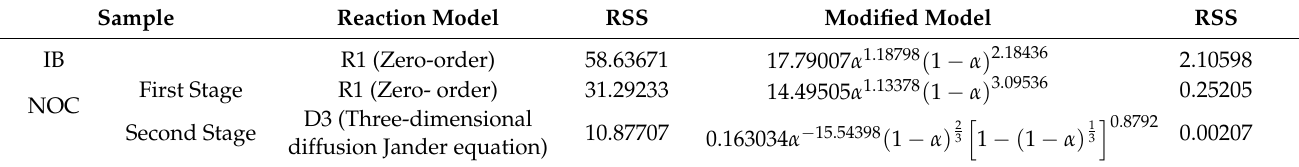
Figure 7. Model reconstruction of the kinetic mechanism function at different heating rates: ( a ) IB, ( b ) NOC. Table 6. Reconstruction model results of IB and NOC dependent on reaction